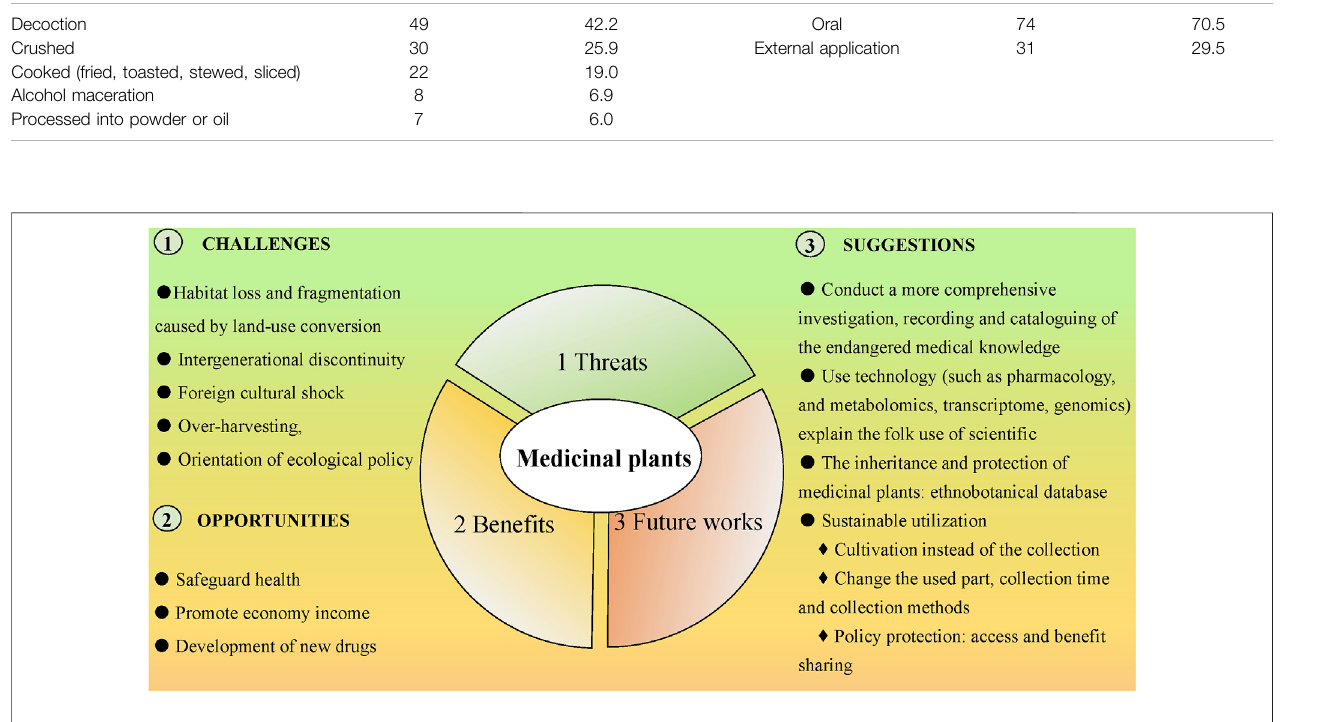
FIGURE 3 | Threats, bene fi ts, and future works of medicinal